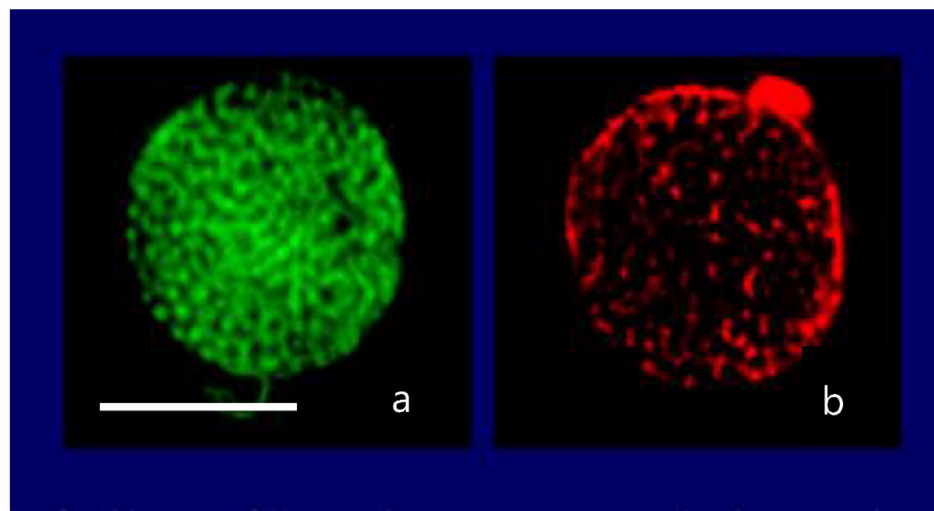
Figure 11. Confocal image of a secretory granule of Karenia brevis demonstrating colocalization of LysoSesor green—that labels secretory granules—in ( a ) and a fluorescent anti-brevetoxin antibody conjugated with Tetramethyl Rhodamine Isothiocyanate that emits in red ( b ). Bar = 10 µ m. The mechanisms whereby Karinia releases toxins to the SW remained unknown, explained by the imaginary untested doctrine of exudation. Fluorescence microscopy images of K. brevis double-labeled with LysoSesor green—that label secretory granules— and fluorescent anti-brevetoxin antibody show that brevetoxin colocalizes inside K. brevis granules. It is, like in other secretory cells, caged inside the condensed matrix K. brevis secretory granules (Figures 10 and